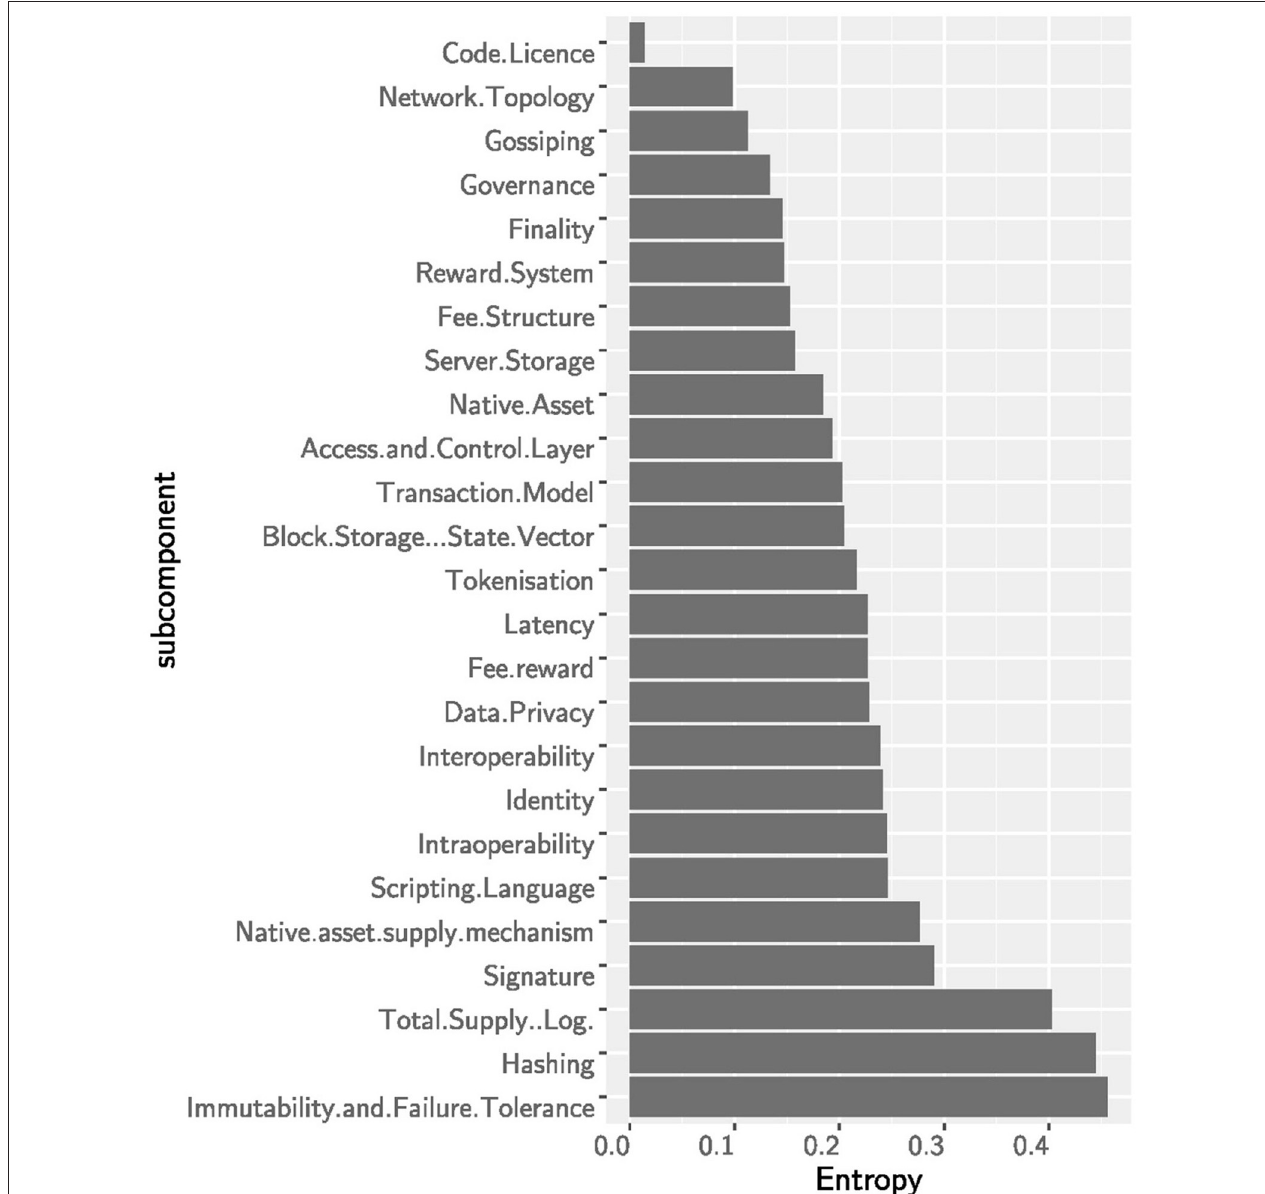
FIGURE 3 | The entropy for the (sub)components: immutability and failure tolerance, the security subcomponents and total supply show the largest entropy. Within these, many new designs have emerged along the sample